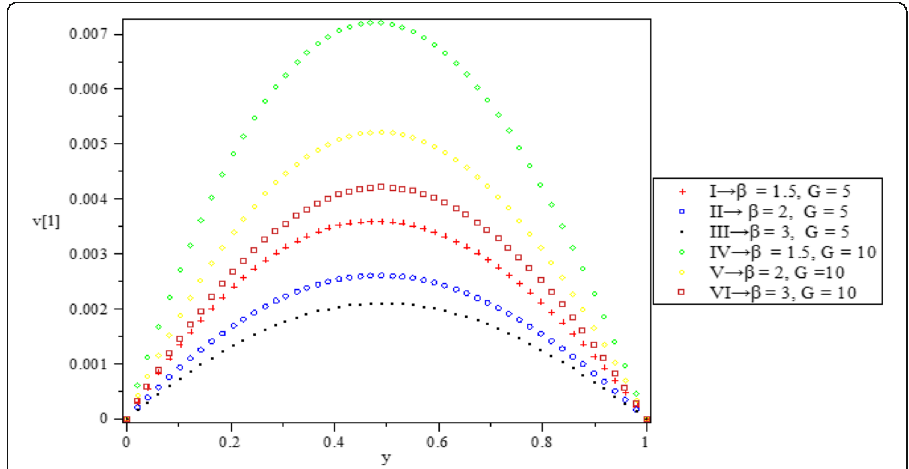
Fig. 27 First-order velocity (v[1] profile, r = − 1, ϵ = 0.25, P = 0.71 α = − 5, and λ = 0.01)